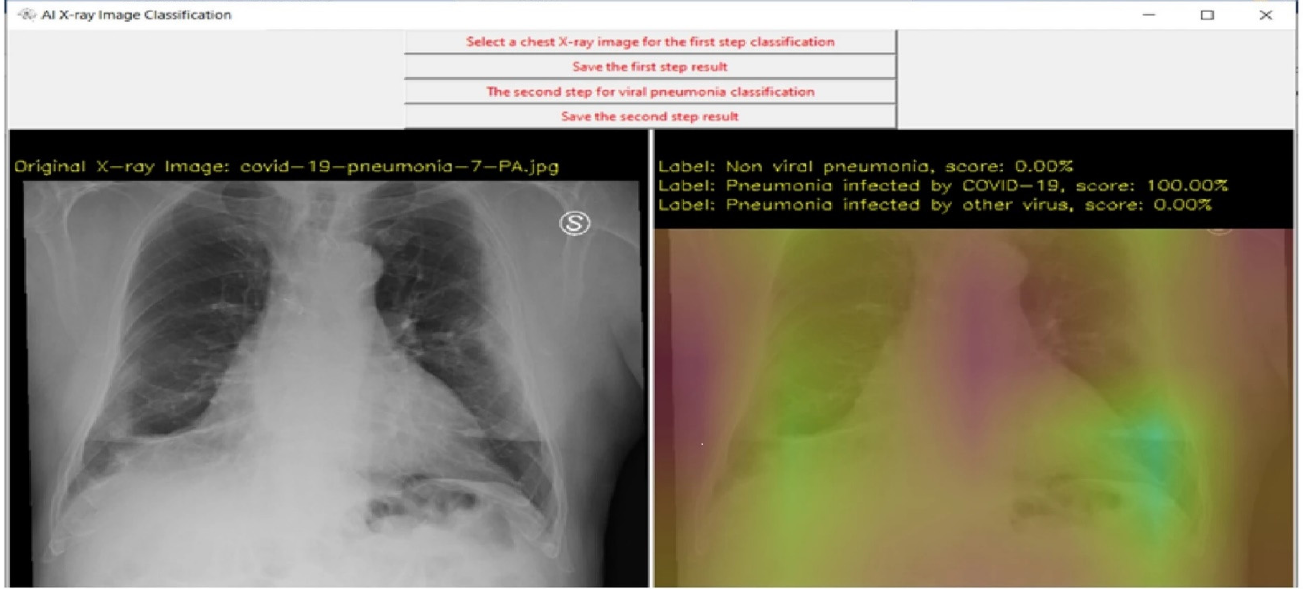
Figure 8. Explainable DCNN for CXR analysis and COVID-19 pneumonia classification.